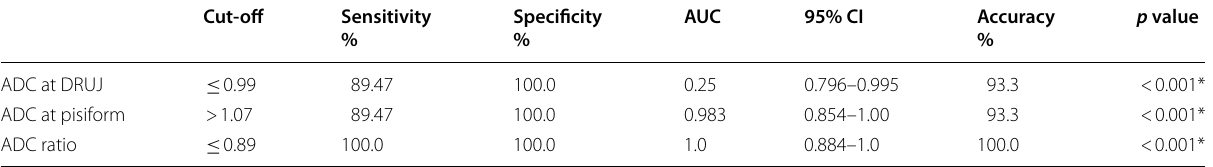
Table 4 Receiver operating characteristics (ROC) curve results for determining the diagnostic accuracy of DW-MRI using ADC values of median nerve in CTS patients